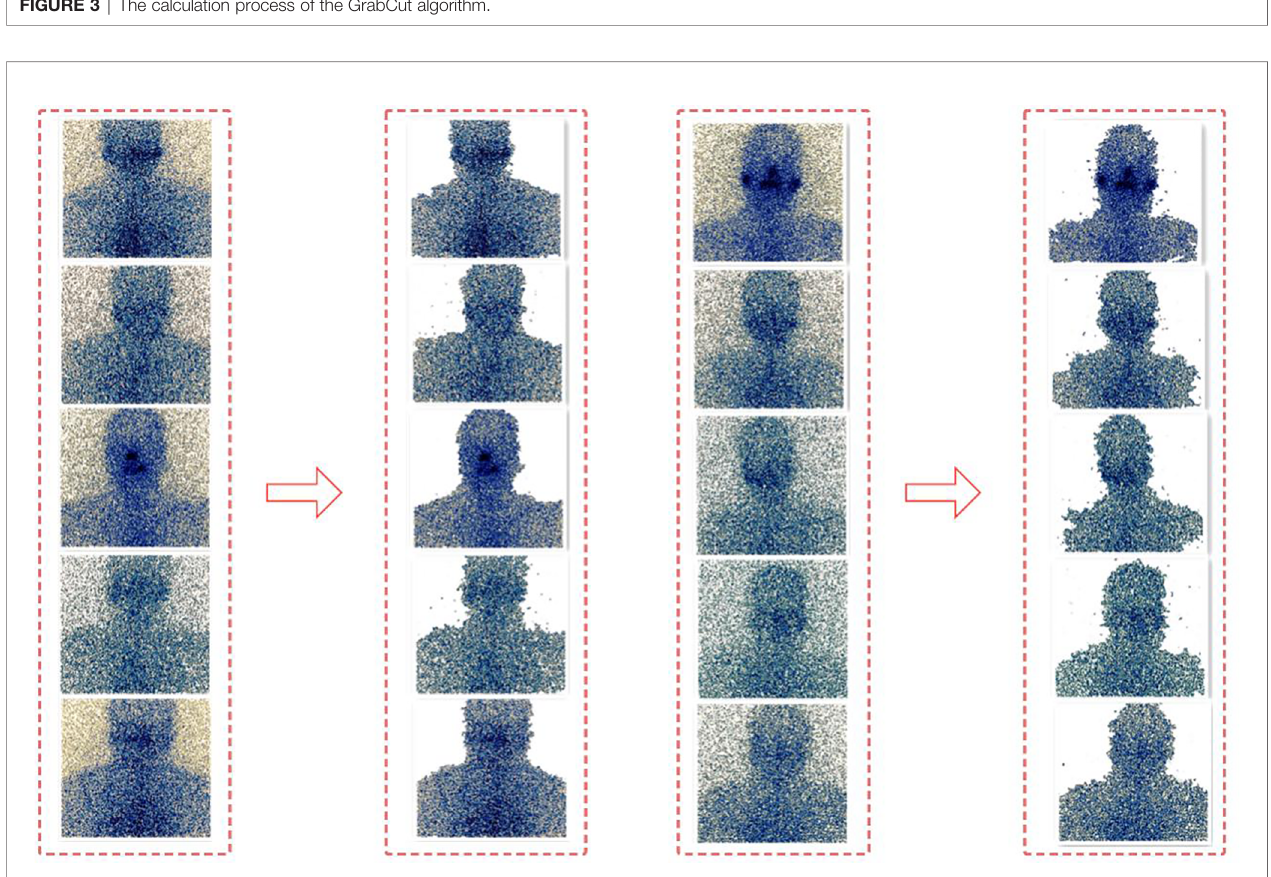
FIGURE 4 | The segmentation effect of Grabcut on the